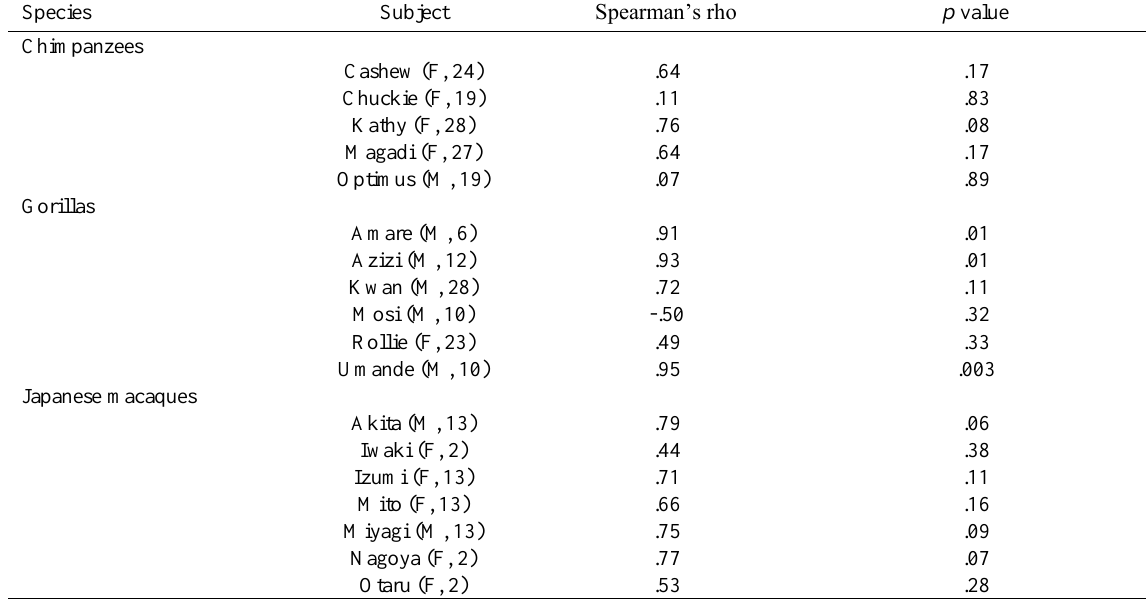
Spearman’s Correlation Results for each Subject’s Worth Values for the Six Foods (Phase 1) Correlated with their Rate of Selecting that Same Food over the Chance Symbol in Phase